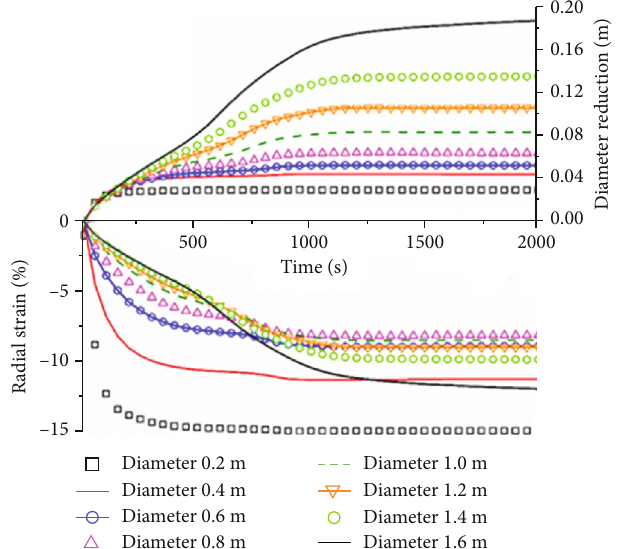
Figure 14: Relationships between radial strain, diameter reduction, and time under di ff erent initial borehole diameters (depth 600 mbsf).